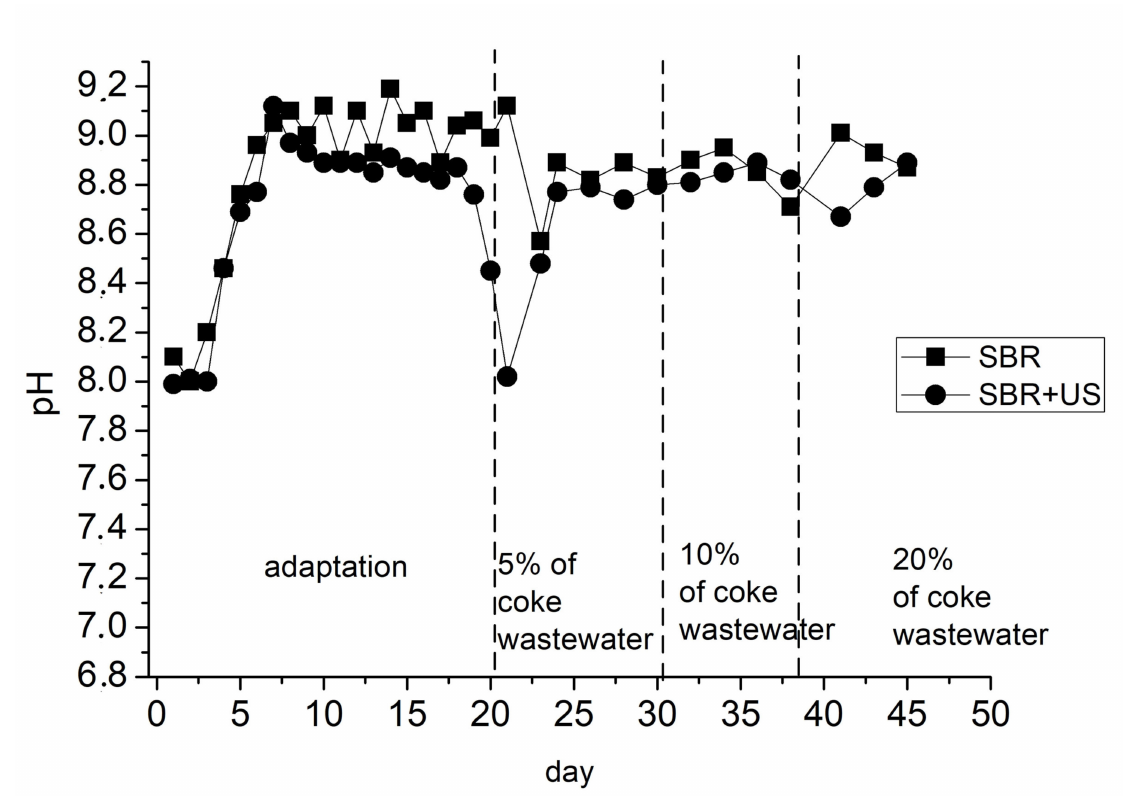
Figure 10. pH changes during treatment in the